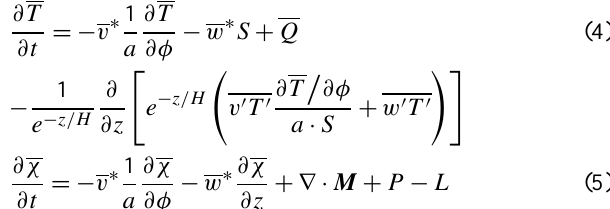
Fig. 4. Linear correlations among the time series of the three up- welling estimates as a function of